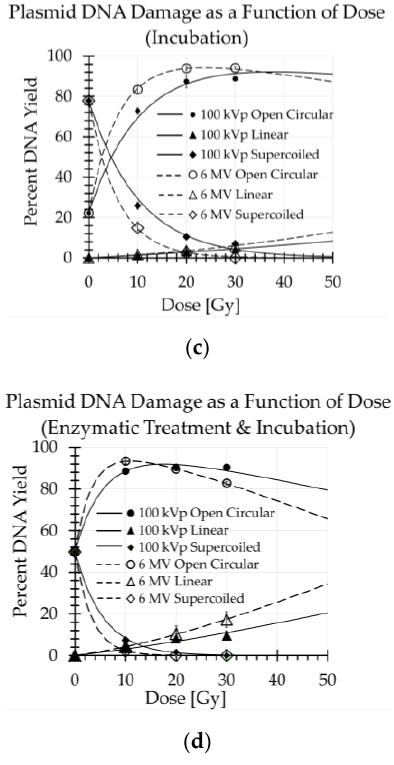
Figure 1. The measured yields at 0, 10, 20, and 30 Gy are plotted and the McMahon and Currell robust plasmid DNA curve fits of the data are displayed for ( a ) control and irradiated samples, ( b ) a magnified view of the linear DNA conformation as a function of dose shown in ( a ), ( c ) samples incubated post irradiation, and ( d ) samples incubated with enzymatic (Nth and Fpg) treatment post irradiation [25].